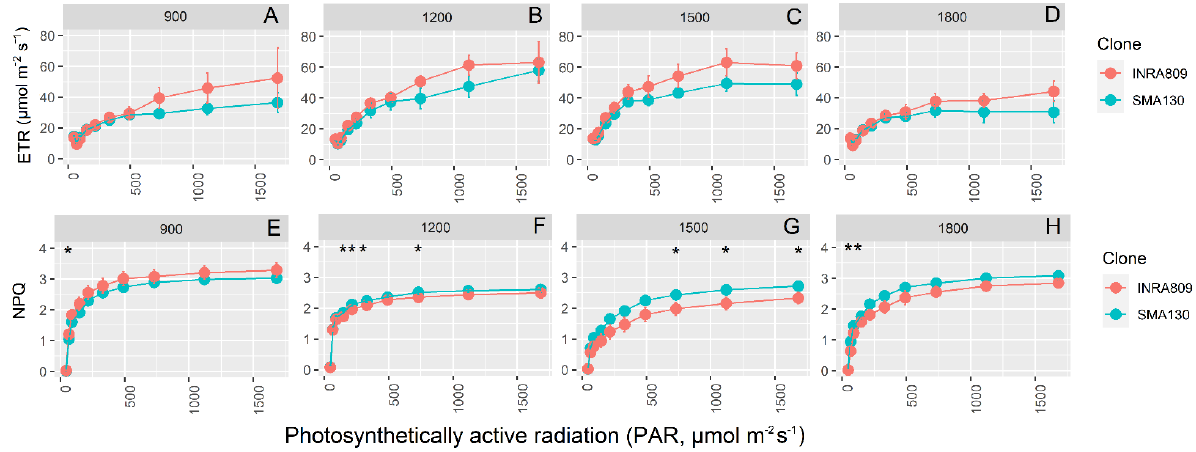
Figure 4. Rapid light curves for INRA809 and SMA130. Electron transport rate (ETR, A – D ) and non-photochemical quenching (NPQ, E – H ) collected in four periods (900, 1200, 1500 and 1800) over the day. For environmental data, see Figure 3A,B. Data are means ( n = 4–6) ± standard error of the means (SEM). Asterisks (*) show significant differences between clones according to t -test for each light level and between clones.